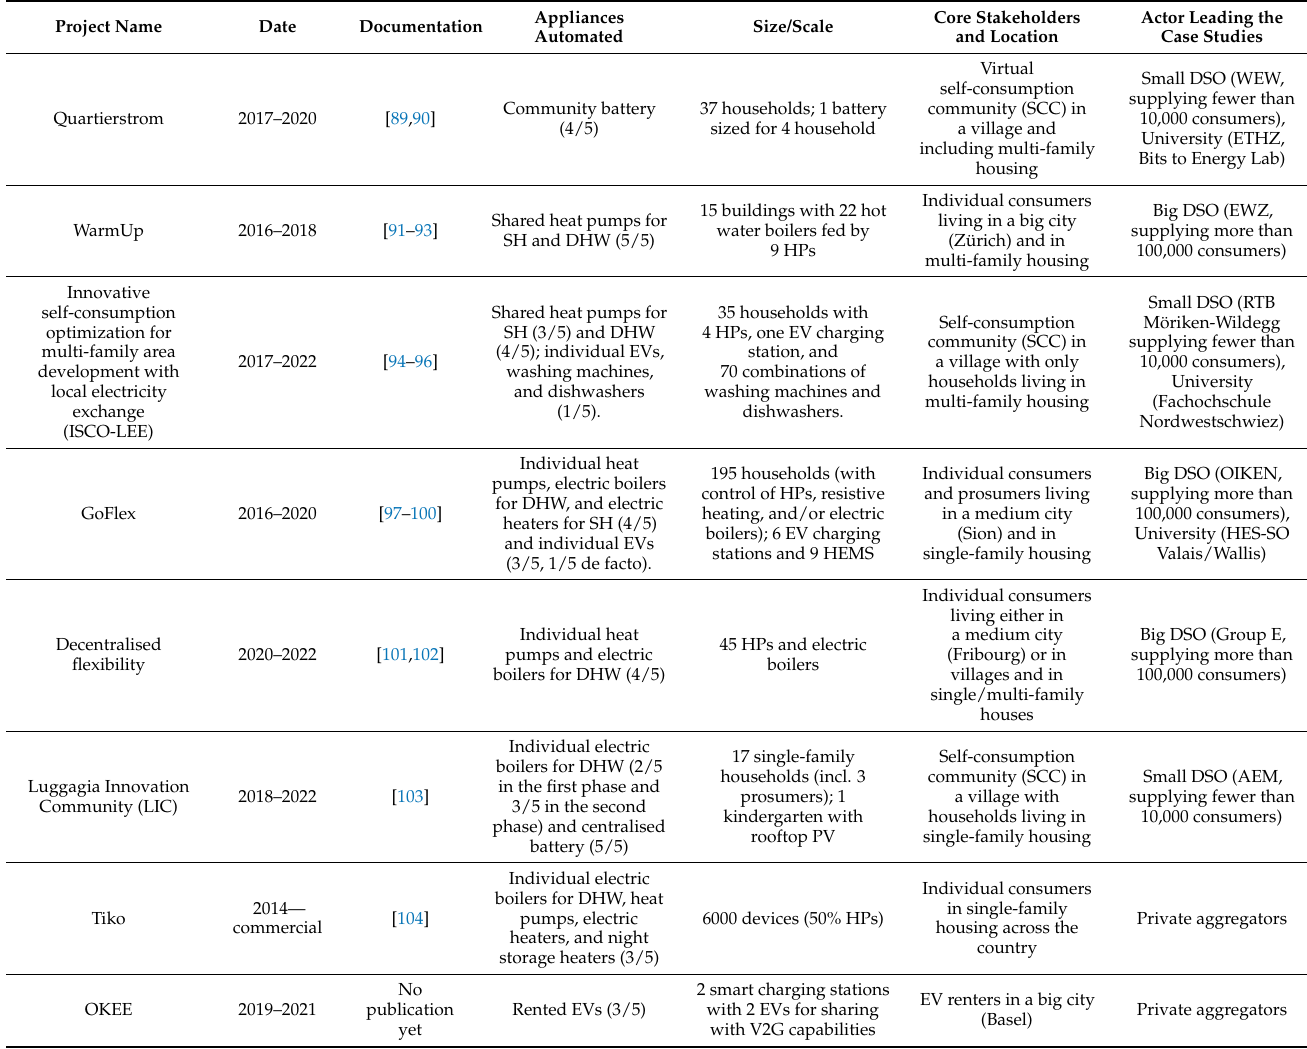
Table 2. Case studies